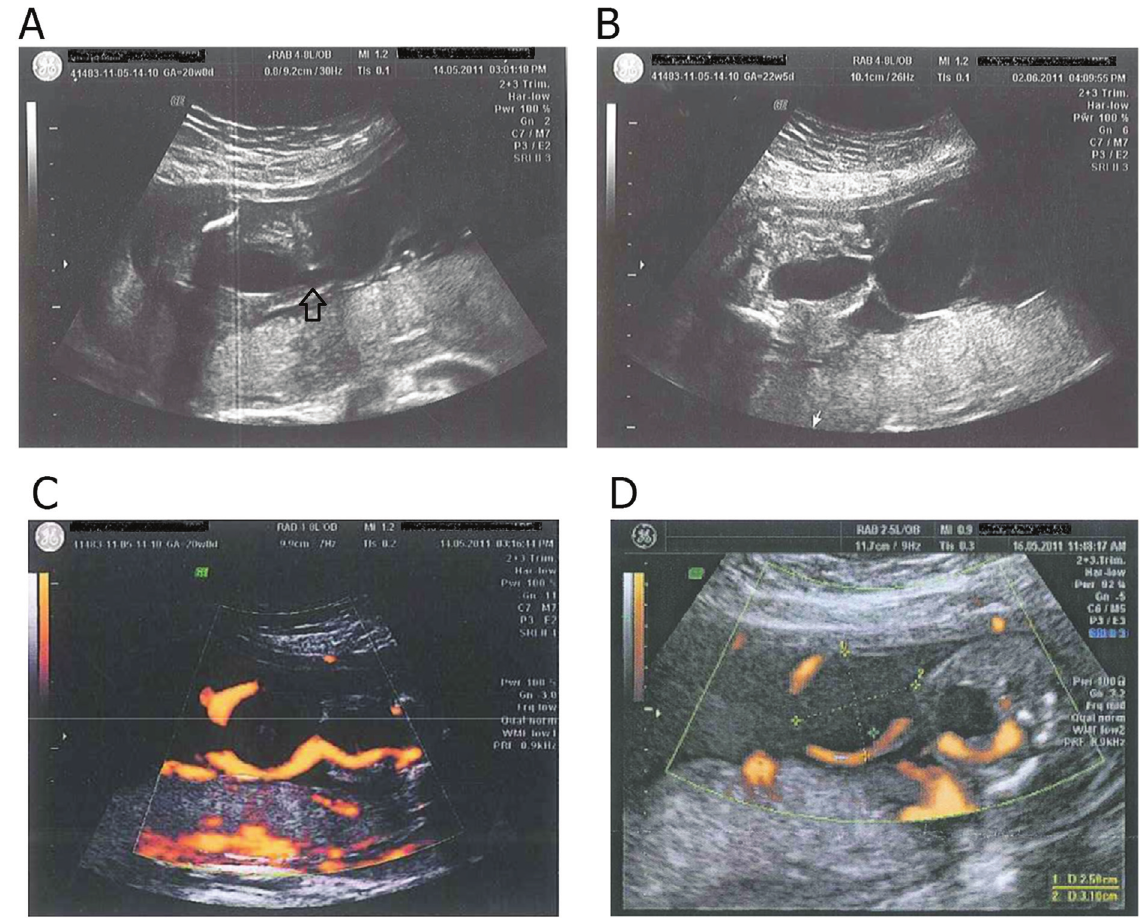
Figure 2. Umbilical cord cyst images. A: Umbilical cord cyst first detected at 20 0/7 weeks of gestation (arrow). B: Umbilical cord cyst was confirmed and a clear image of the connection between the bladder and the umbilicus was found at 22 5/7 weeks of gestation. C: Doppler velocimetry demonstrated flow around the cyst. D: Doppler ultrasound examined the size of the